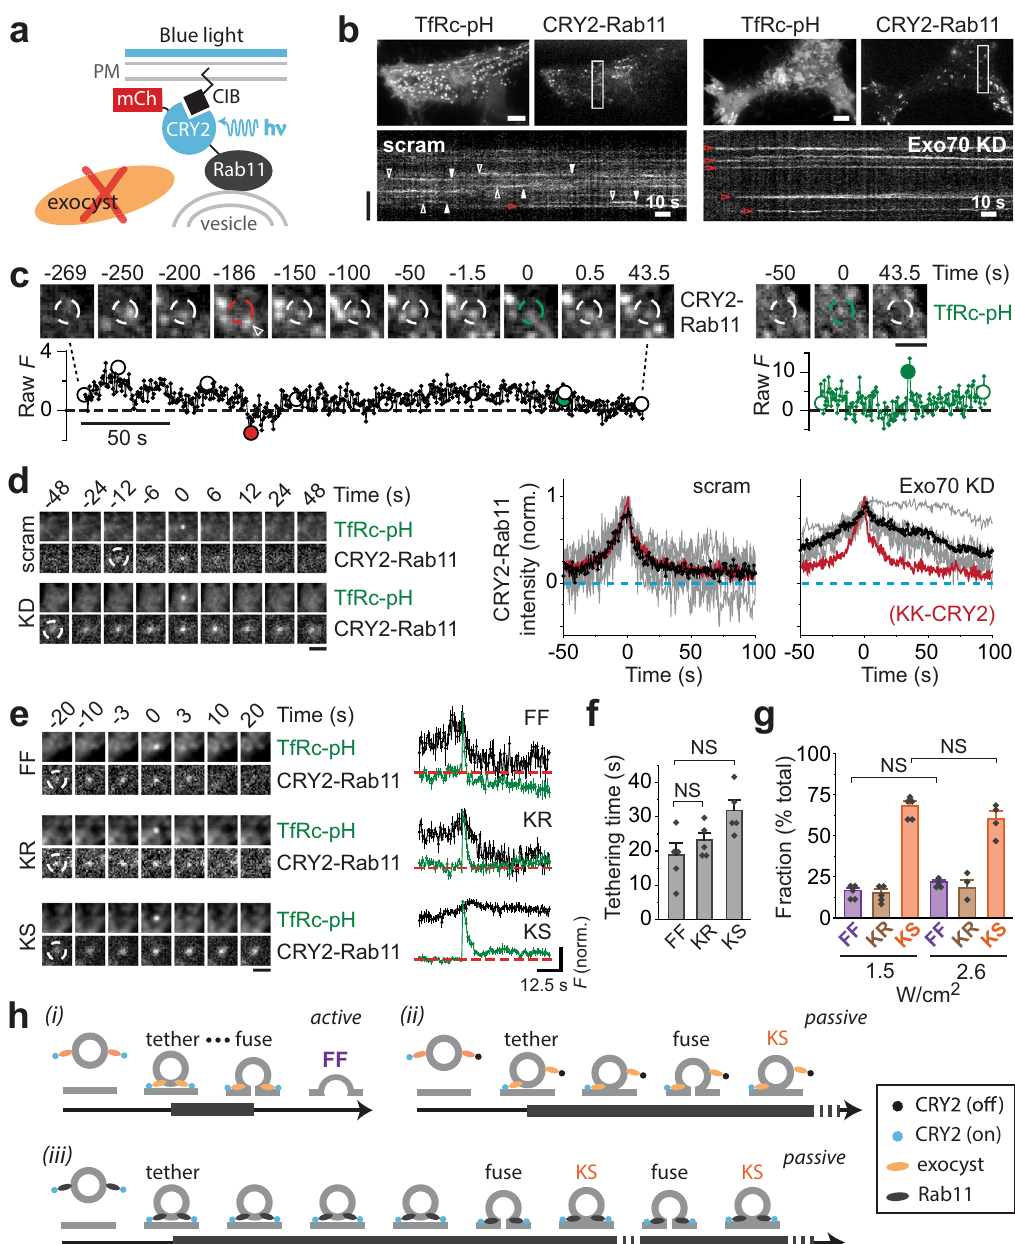
Fig. 5 Rab11 optogenetics in Exo70 KD cells does not rescue full fusion. a Schematic of Rab11 optogenetics using the CRY2-CIB system. b Rab11 optogenetics with or without Exo70 KD. Maximum-intensity projection of movies (top). Scale bars, 6 μ m. Kymographs of Rab11 channel (bottom). Red arrowheads, stuck vesicles. Vertical scale bar, 6 μ m. c Images of a single vesicle undergoing very long tethering (left, black) and fusion (right, green). Colored circles in the traces (bottom) correspond to dashed circles in the image frames (top). Scale bar, 2 μ m. d Average image sequence of fusing vesicles from one cell (left). Scale bar, 2 μ m. CRY2-Rab11 traces, time aligned to fusion (right). Averages (bold line) of cell averages (light lines) are shown. n = 5 cells for both scram and Exo70 KD. For comparison, the thick red line redisplays the average Exo70 trace from the Exo70-KK – CRY2 ( + CIB) optogenetics experiment. Dashed cyan lines, zero baseline. e Three fusion modes observed with CRY2-Rab11 activation ( + Exo70 KD) using 100 mM HEPES. Average image sequence of FF, KR and KS events from one cell (left). Scale bar, 2 μ m. TfRc-pH (green) and CRY2-Rab11 (red) traces (average of cell averages) for all fusion modes (right). Mean± SEM. Red dashed lines, zero baseline. f Tethering half-times for different fusion modes. Mean± SEM (NS = not signi fi cant, two-tailed Student ’ s t -test. g Frequency of fusion modes with Rab11 optogenetics at different light doses. Note that 1.5 W/cm 2 was used in b to f . Mean± SEM (NS = not signi fi cant, two-tailed Student ’ s t -test). h Schematic summary of Exo70-KK (Fig. 2) and Rab11 optogenetics results. During active tethering, optimal engagement of exocyst leads to FF (i). This model entails coupling between vesicle tethering and fusion (dots). Passive tethering occurs when the exocyst is suboptimally engaged (ii) or when vesicles are arti fi cially tethered without the exocyst (iii). Note, for clarity, only two copies of exocyst are